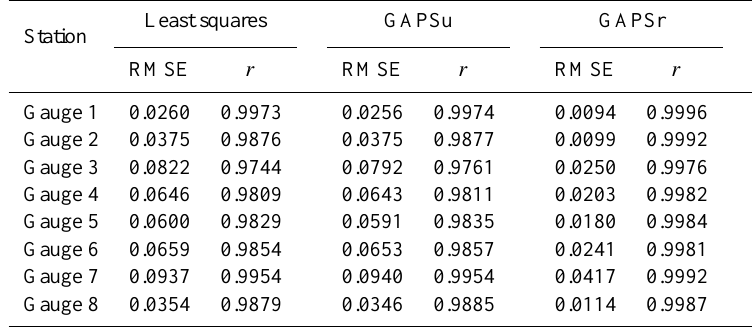
Table 1. Summary of statistical evaluations based of the proposed cost function. Least squares GAPSu GAPSr Station